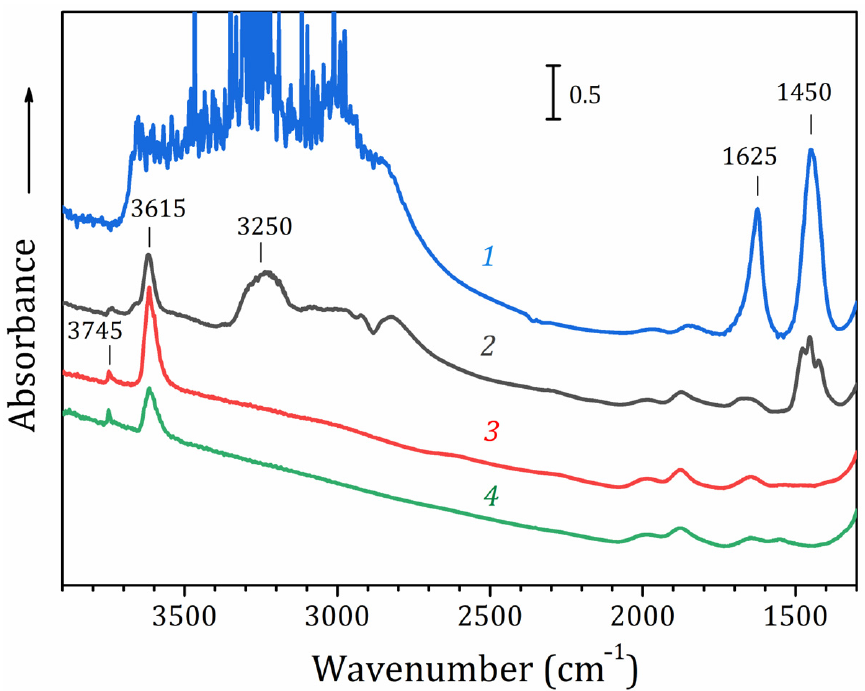
Figure 7. FTIR spectrum of H-MOR-15.0; 6.25 mg/cm 2 at ambient temperature before treatment ( 1 ) and at − 196 °C after evacuation at 300 °C ( 2 ), 450 °C ( 3 ) and 600 °C ( 4 ).